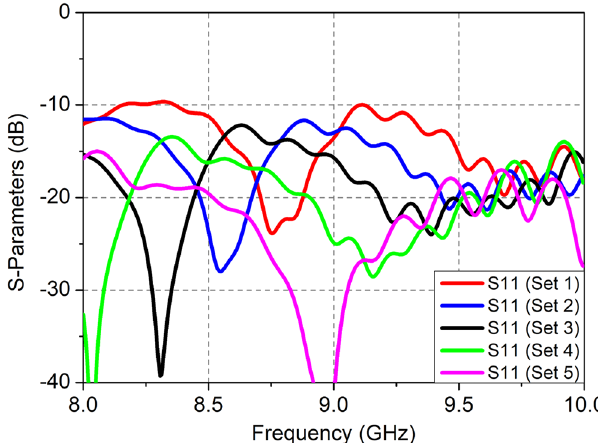
Fig. 9. Simulated result of the S11 of the designed antenna according to the set numbers.